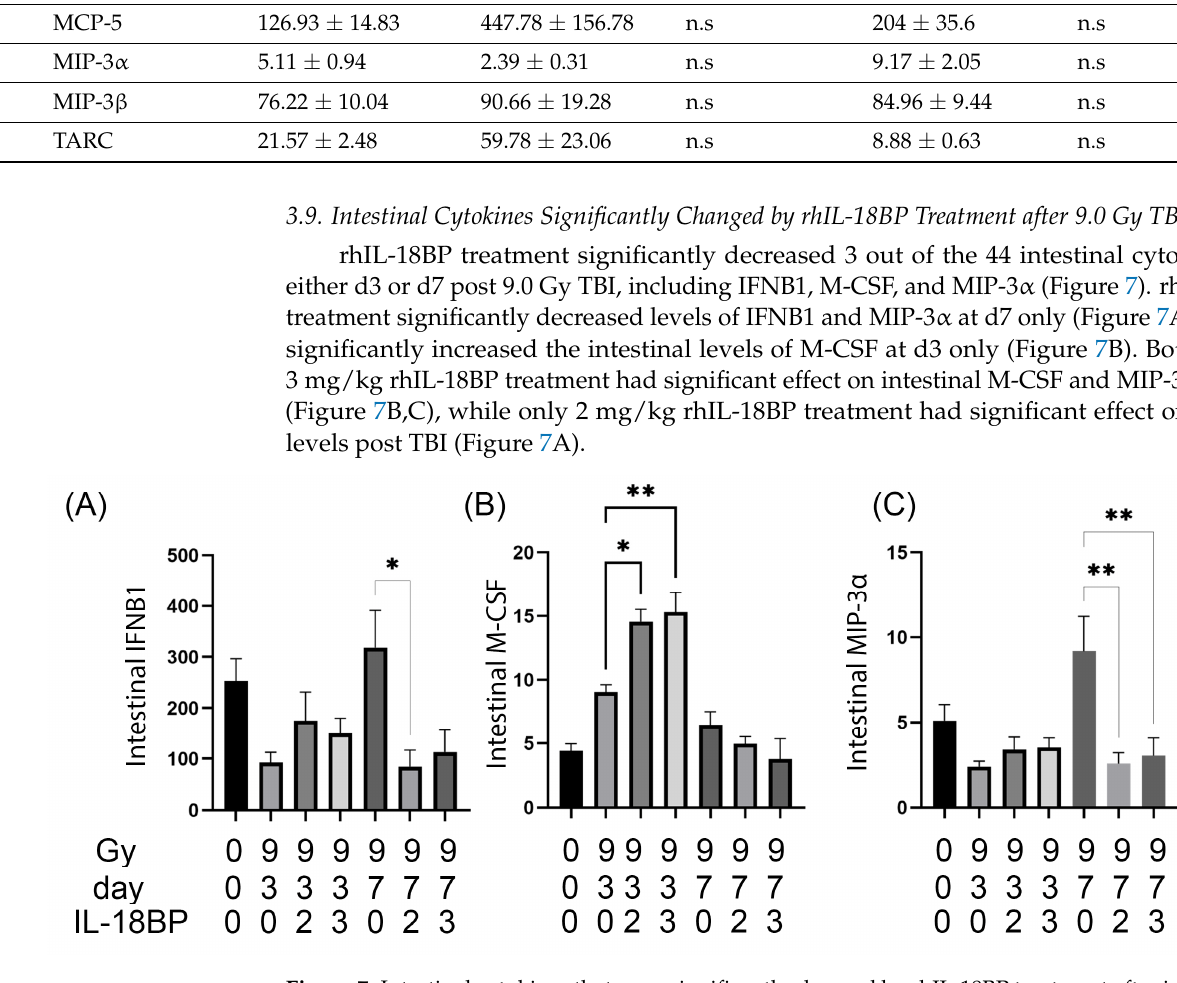
Figure 7. Intestinal cytokines that were significantly changed by rhIL-18BP treatment after irradiation. Radiation dose, time points after irradiation, and IL-18BP dose (mg/kg) were shown below the graphs. ( A ) intestinal IFNB1 levels, ( B ) intestinal M-CSF levels, ( C ) intestinal MIP-3 α levels. All cytokines’ concentration unit was pg/mL. 0 Gy samples were not included for statistical analysis to simplify the view. *, p < 0.05; **, p < 0.01.